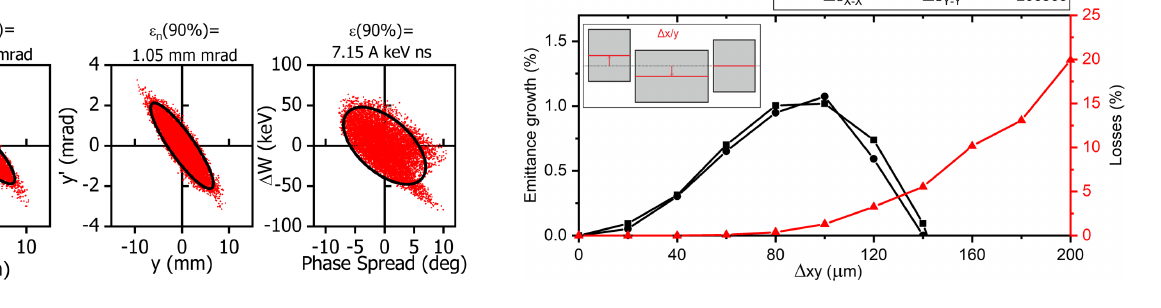
FIG. 26. Transverse and longitudinal particle distributions at the linac exit.